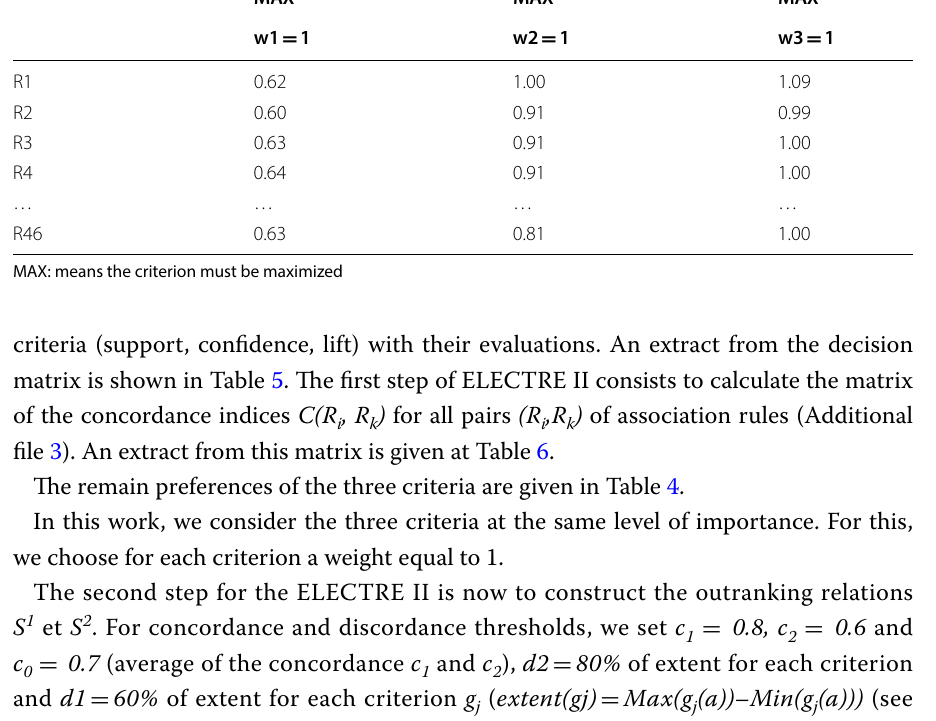
Table 5 Matrix 46 Alternatives